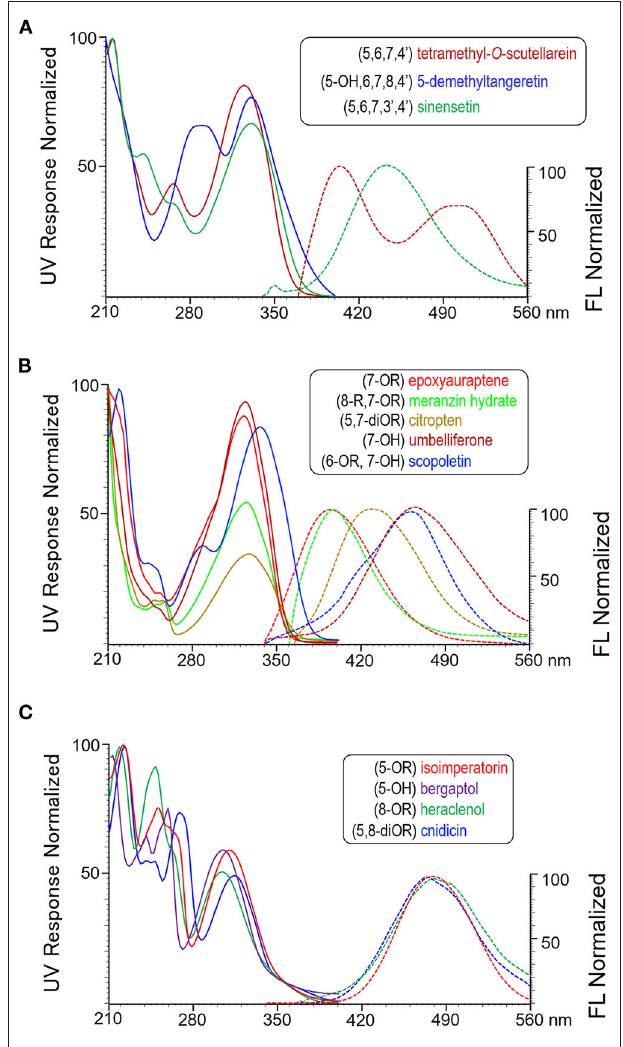
FIGURE 1 | Representative UV absorbance and fluorescence emission spectra of the subgroups of three OHA families, (A) methoxyflavones, (B) coumarins, and (C) furanocoumarins. UV spectra are shown in solid lines and ranged between 210nm and 400nm. Fluorescence spectra are shown in dash lines and ranged between 340nm and 560nm. All signals are